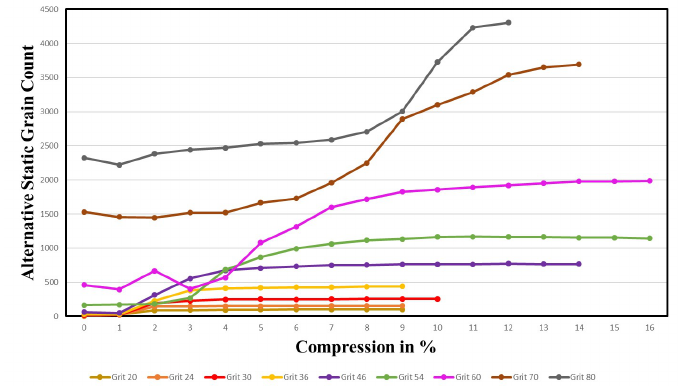
Figure 20. Alternative static grain count dependent on different percentages of